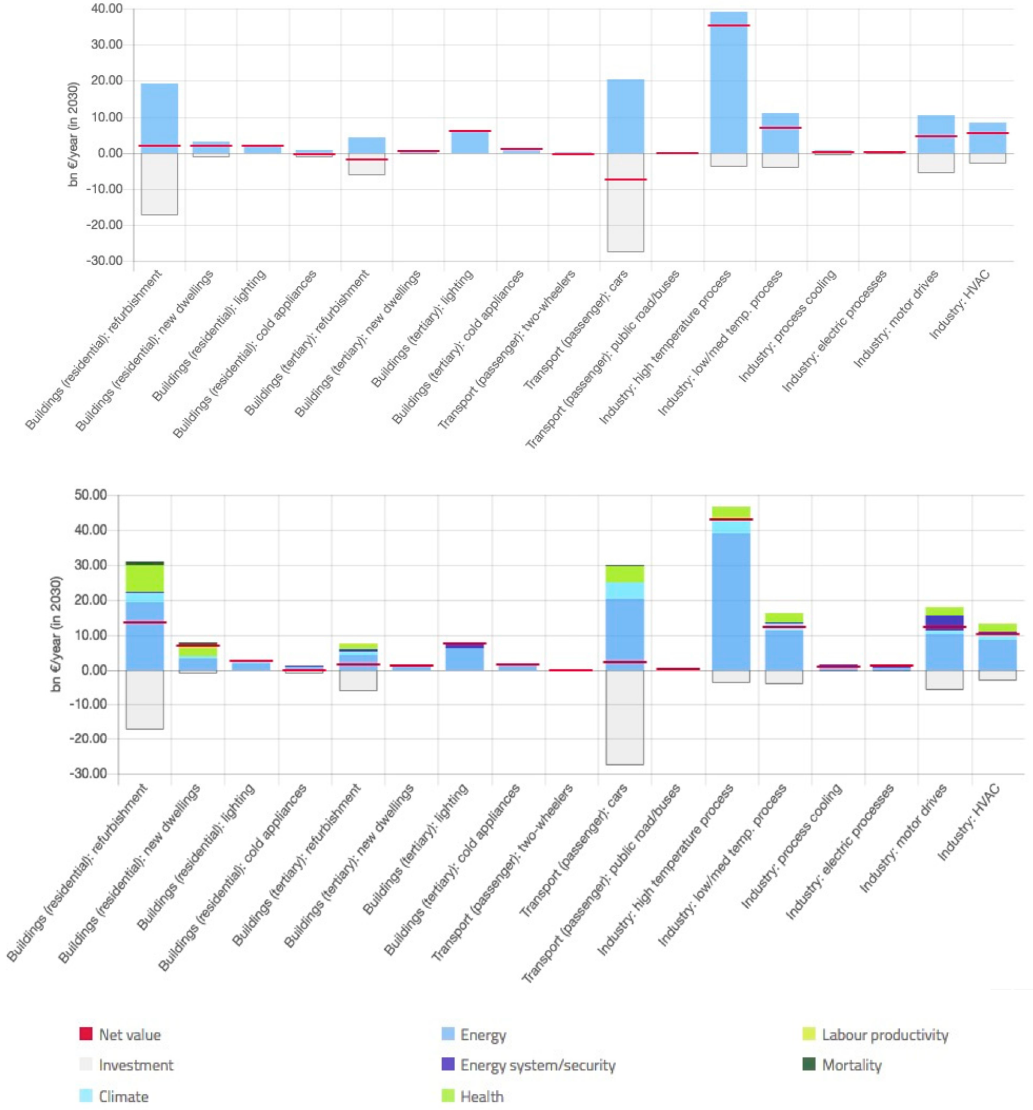
Figure 2. Cost-benefit analysis of EEI actions across EU28 (bn€ per year in 2030). Upper graph: excluding and lower graph: including MI (excluding modal shift and trucks).